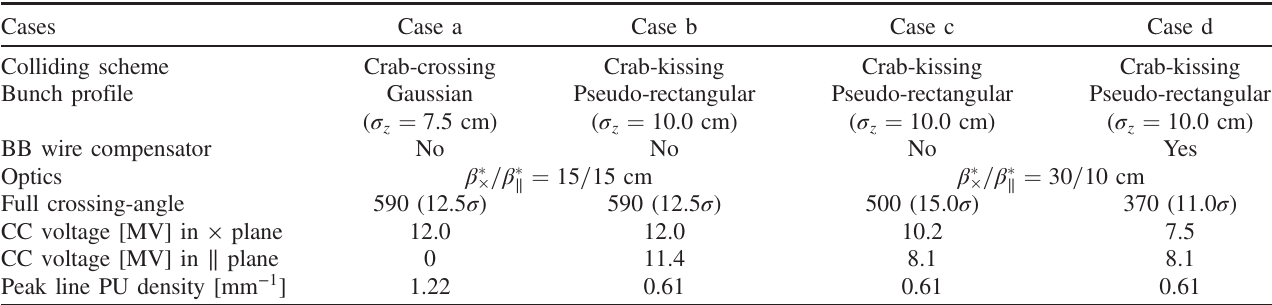
¼ 135 ) and need in terms TABLE III. Peak line pile up density for the HL-LHC beam (worst case at L 0 ¼ 5 × 10 34 cm − 2 s − 1 , i.e., μ tot of crab-cavity (CC) voltage for a few selected configurations in terms of bunch profile (Gaussian or pseudorectangular), colliding scheme (crab-crossing or crab-kissing), optics (round or flat) and crossing angle (with electromagnetic wires assumed in the fourth case to mitigate the long-range beam-beam interactions at smaller crossing angle). Crab-crossing Crab-kissing Crab-kissing